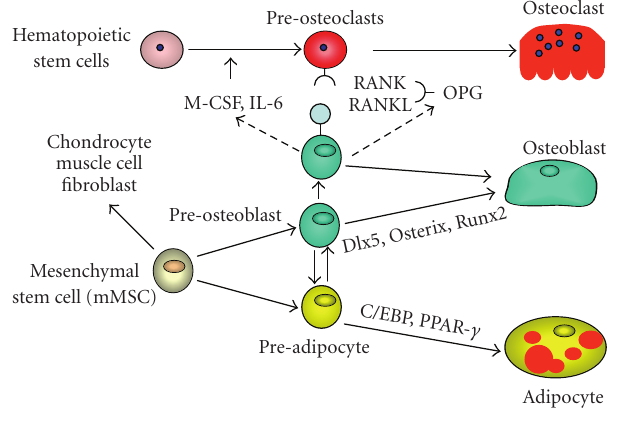
Figure 1: Schematic representation of bone cell development.